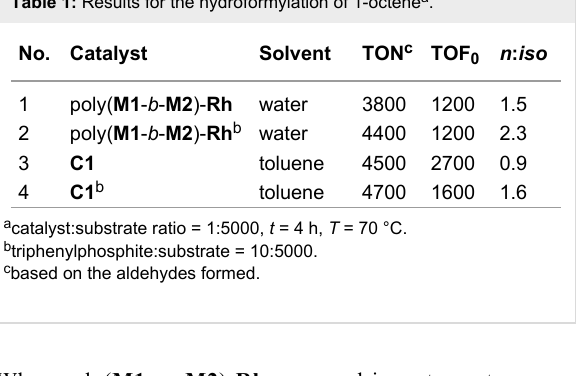
Table 1: Results for the hydroformylation of 1-octene a